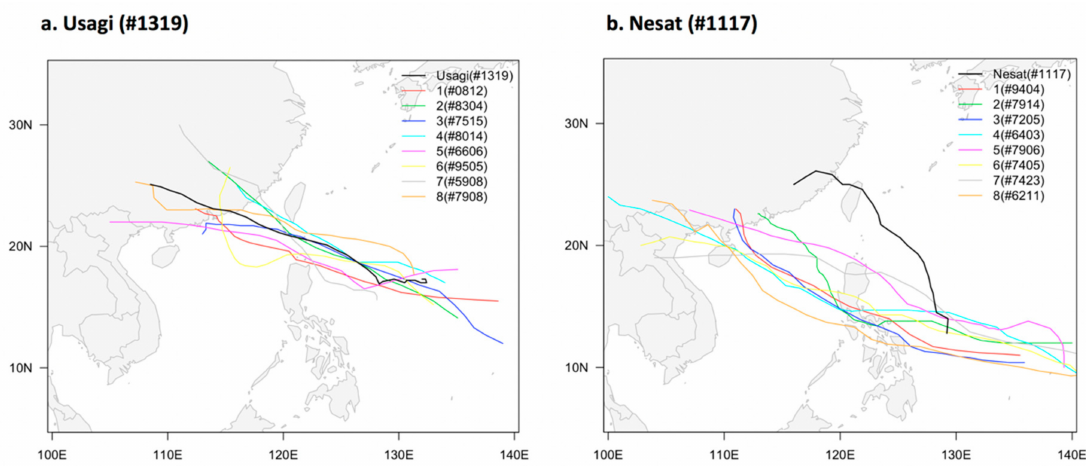
Figure 2. Top eight typhoon tracks most similar to those of: ( a ) Usagi (#1319) and ( b ) typhoon Nesat (#1117). The identification number and similarity level of the selected typhoons are indicated in the